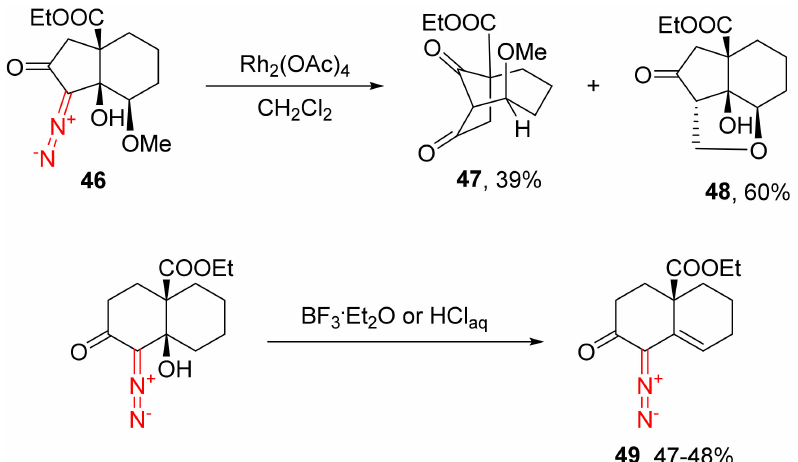
Scheme 29. Rh(II)-catalyzed transformations of substrates 46